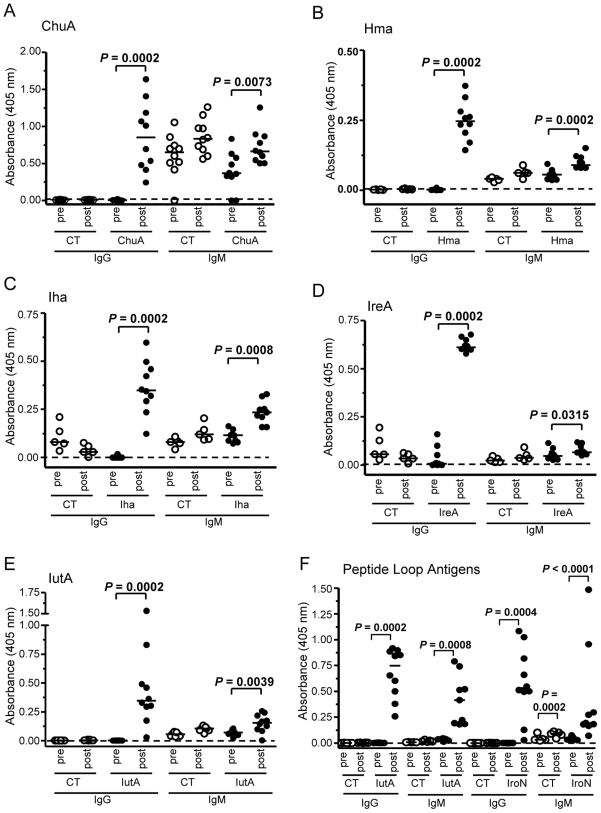
Antigen-specific serum IgM and IgG is produced in vaccinated mice.Serum from (A) ChuA-vaccinated, (B) Hma-vaccinated, (C) Iha-vaccinated, (D) IreA-vaccinated, (E) IutA-vaccinated, (F) IroN and IutA extracellular loop peptide antigens and corresponding CT control-treated mice was collected prior to vaccination (pre) and after vaccination before transurethral challenge with UPEC strain CFT073 (post). Samples were plated in duplicate in appropriately coated ELISA plates and probed for relative IgG and IgM. Open circles represent CT control mice and closed circles represent vaccinated mice. Each circle represents an individual animal and bars represent the median. Significance was determined using a two-tailed Mann-Whitney test.